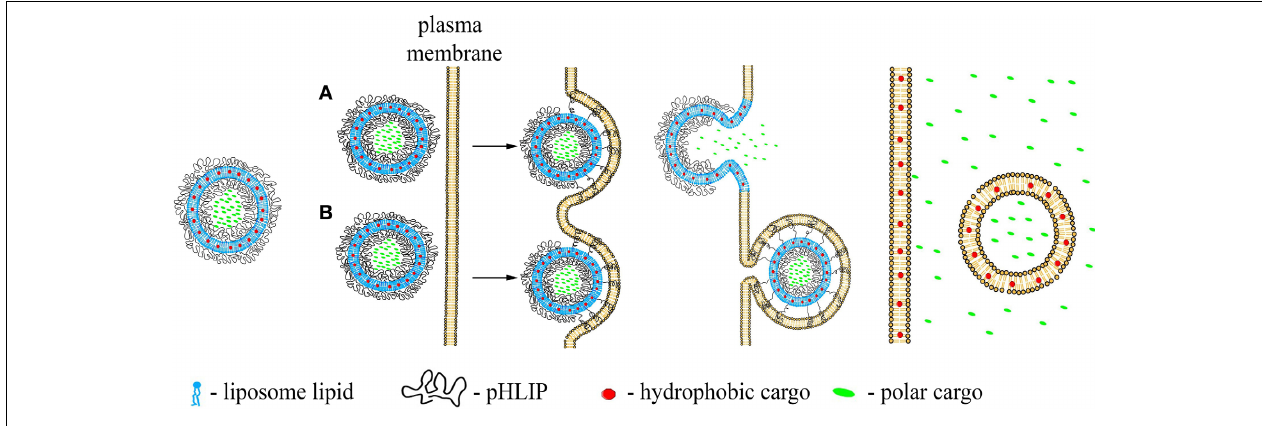
FIGURE 2 | Schematic presentation of pHLIP-coated liposome entry into a cell. pHLIP coated Liposomes with encapsulated polar cargo molecules or carrying hydrophobic cargoes in their bilayers can deliver payloads to cell